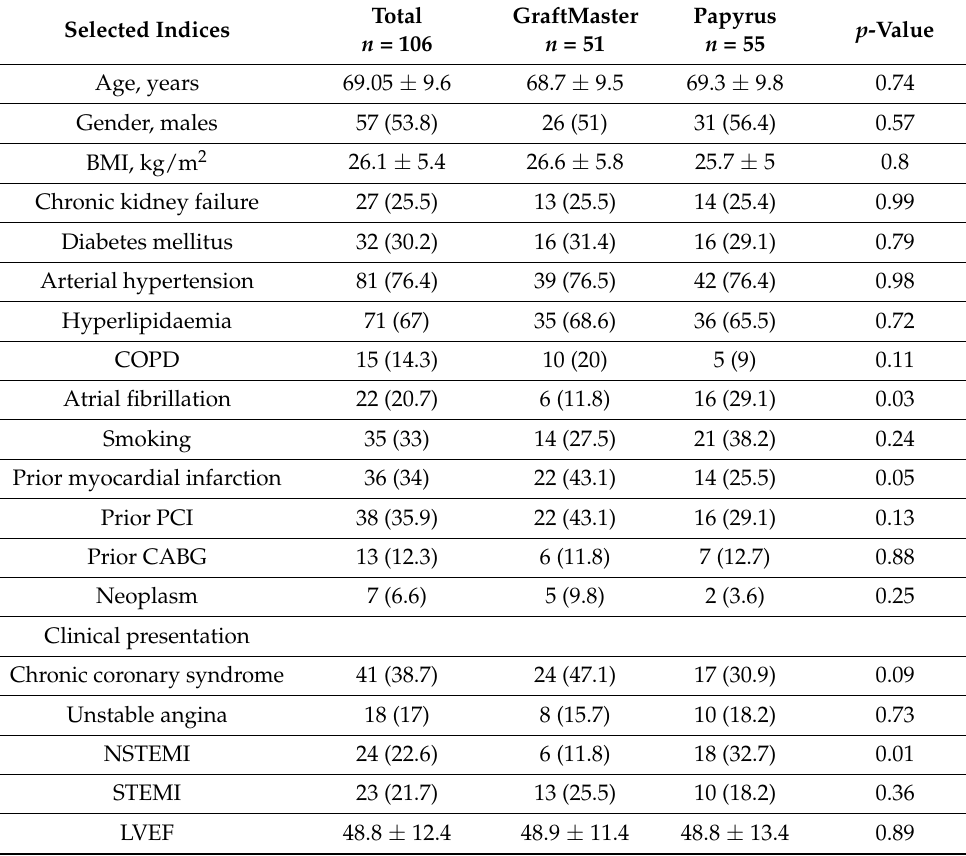
Table 1. General characteristics and left ventricle ejection